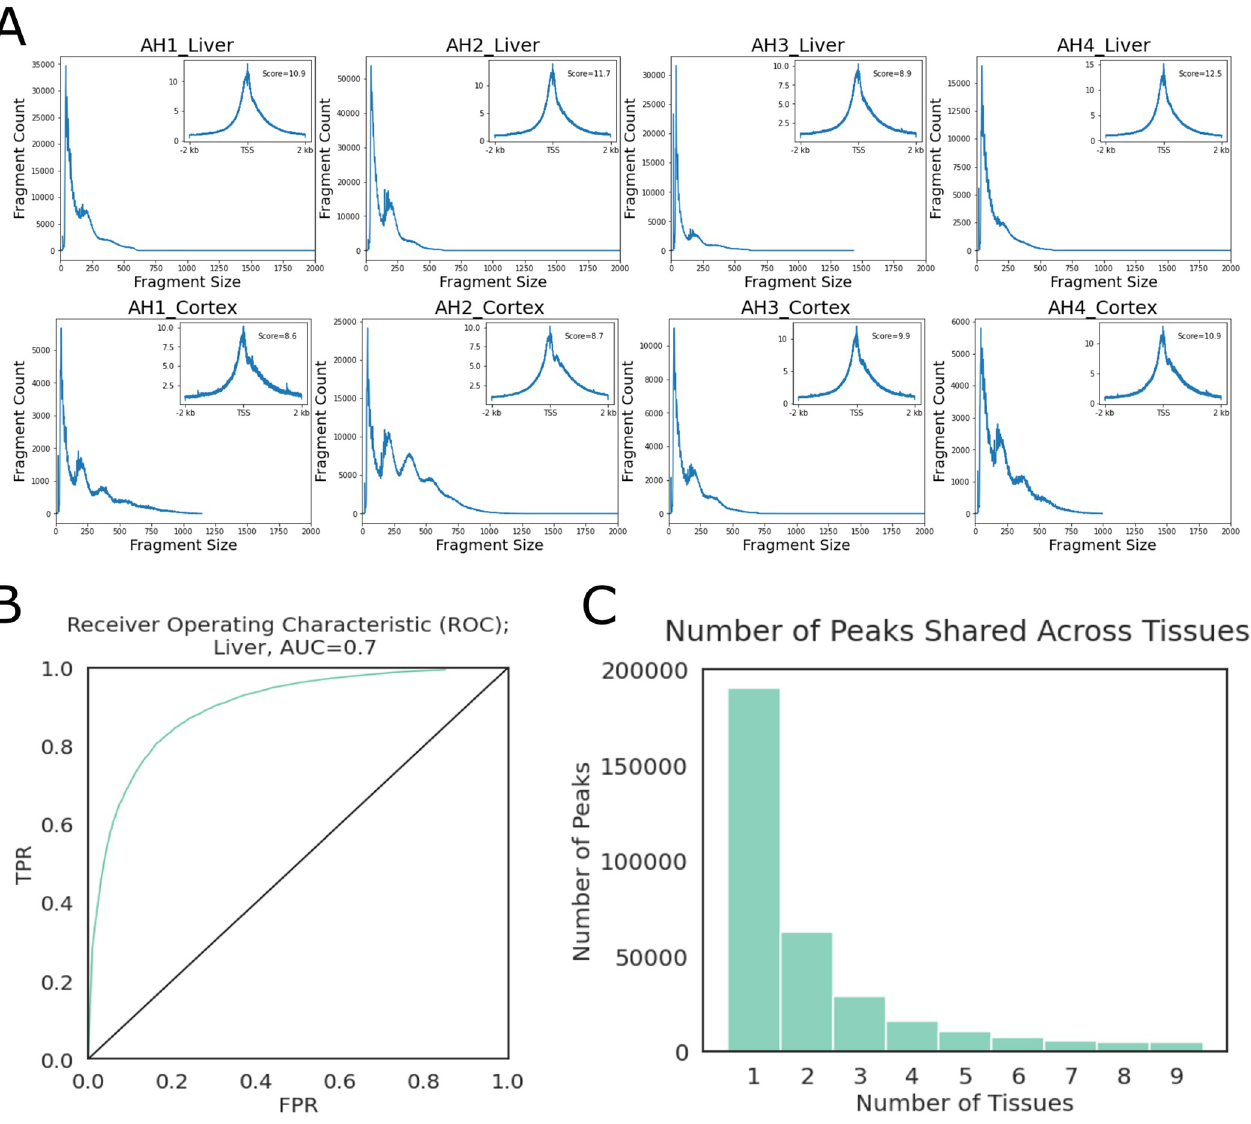
Fig 3. ATAC-seq Quality Control. (A) Fragment size distributions and TSS enrichment plots (upper right inset plots) of liver and cerebral cortex samples as examples. (B) ROC plot of liver peaks, as a representative example across tissues. TPR: true positive rate, FPR: false positive rate, AUC: area under curve. (C) Number of peaks that were observed in a given number of